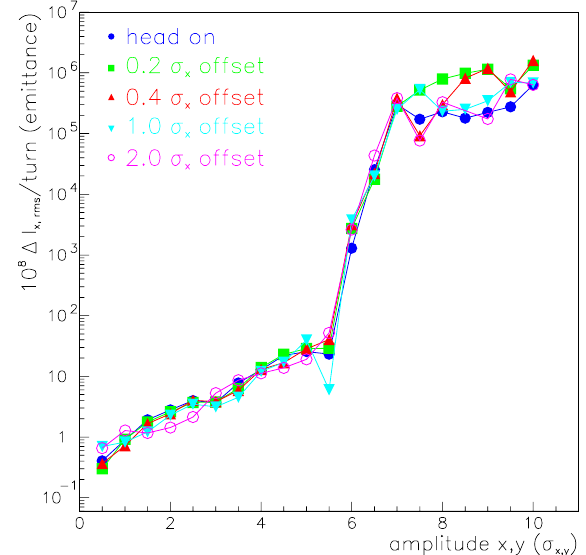
FIG. 13. (Color) The change of action variance per turn (in units of rms emittance times 10 2 8 ) as a function of the starting amplitude for different transverse offsets at one of the two main